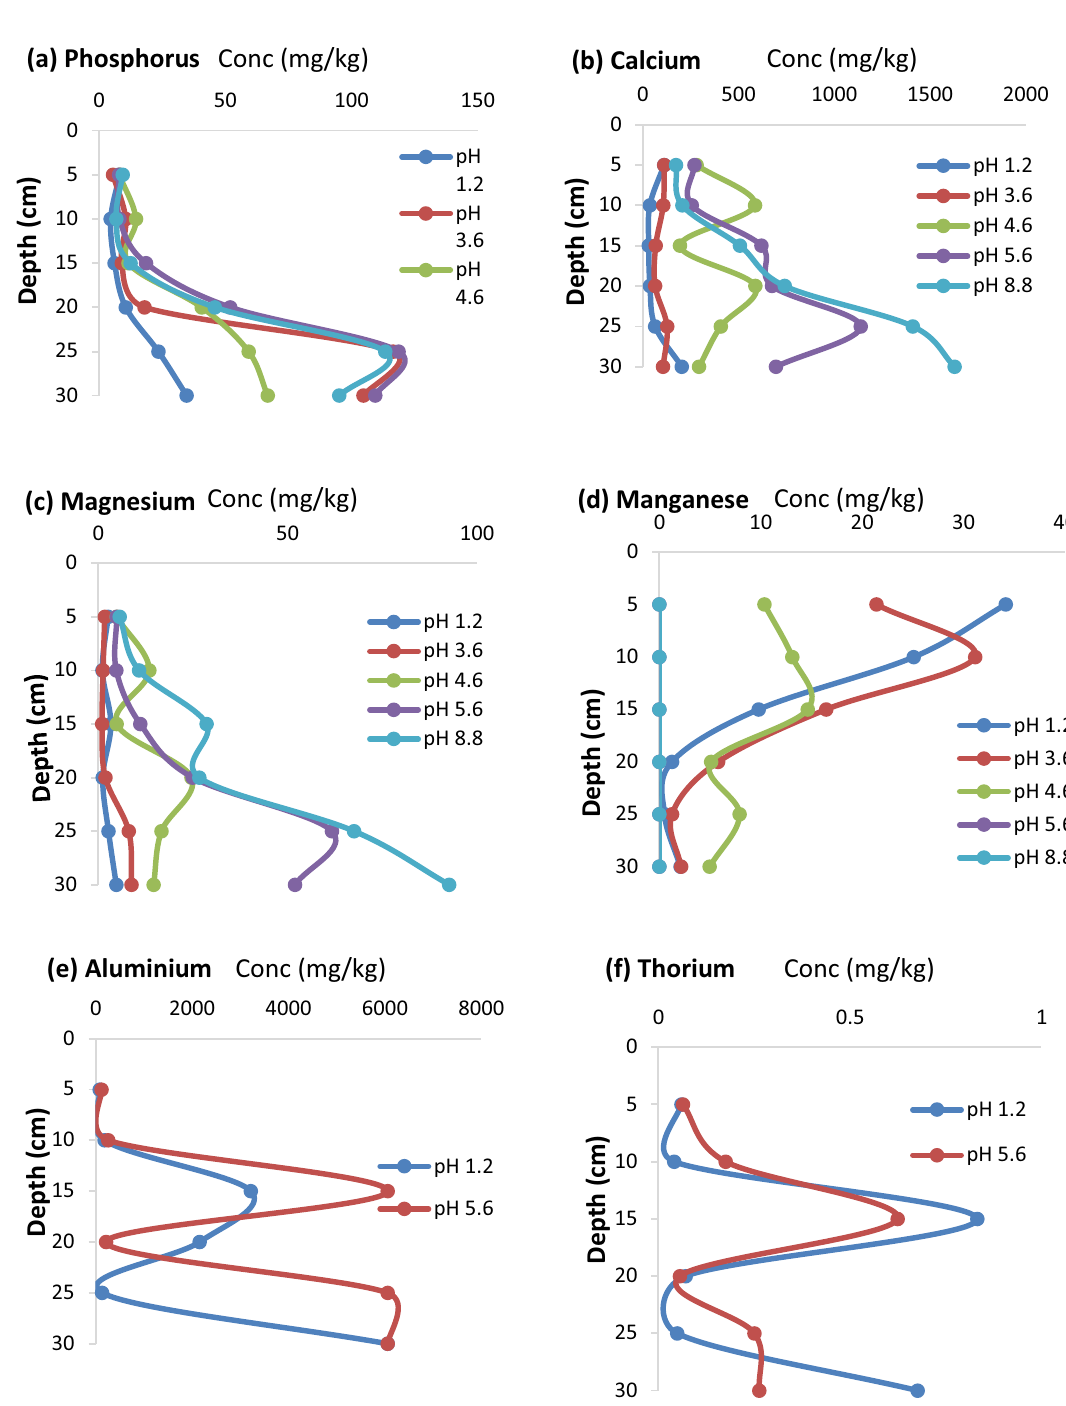
Figure 6. The concentration of residual ions in PG organic amended sandy soil with the depth of soil column after 30-day leaching with different of pH of